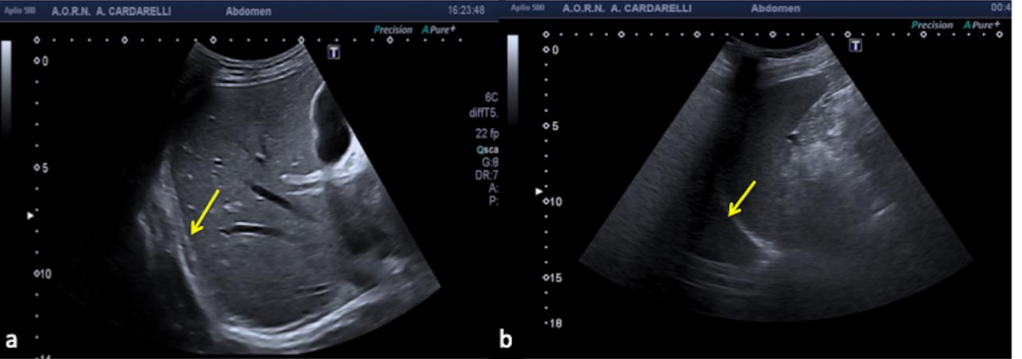
Figure 20. Subcostal US right approach ( a ) shows a hypo-anechoic elongated image (arrow) simulat- ing a small right pleural effusion. Coronal US scan of the left hypochondrium ( b ) shows a mirror artifact that duplicates the image of the spleen (arrow) and mimics pleural effusion.